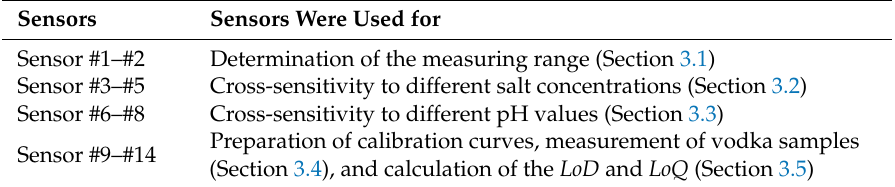
Table A1. Overview of all hydrogel-based ethanol sensors including their measurement